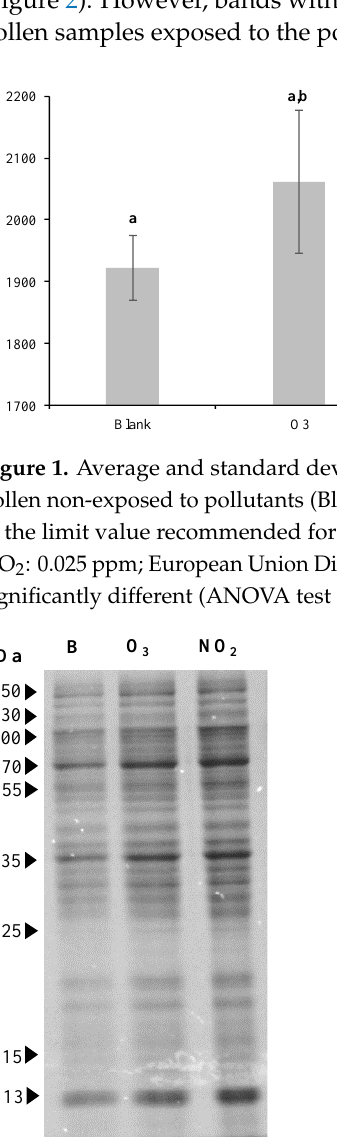
Figure 2. Results of SDS-PAGE gel of total soluble proteins from Dactylis glomerata pollen extracts non-exposed to pollutants (B; lane 1) and exposed to O 3 (lane 2) and NO 2 (lane 3) gaseous pollutants during 6 h at the limit value recommended for the protection of human health in Europe (O 3 : 0.061 ppm and NO 2 : 0.025 ppm; European Union Directive 2008/50/EC). The molecular weight of the bands is expressed in kDa.